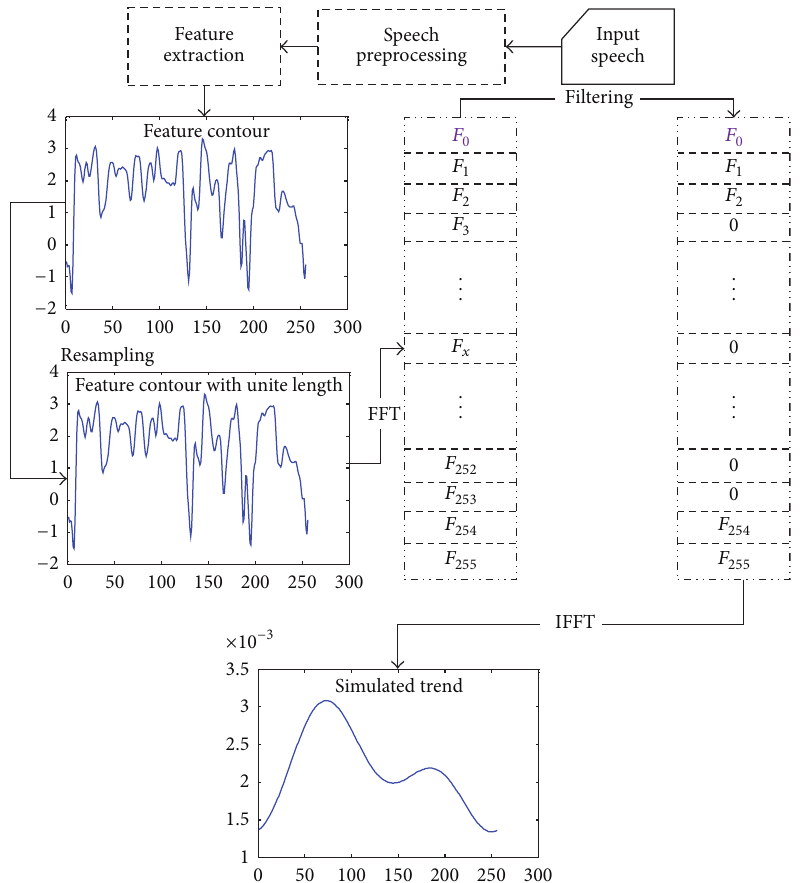
Figure 2: Flowchart to obtain the approximated speech feature